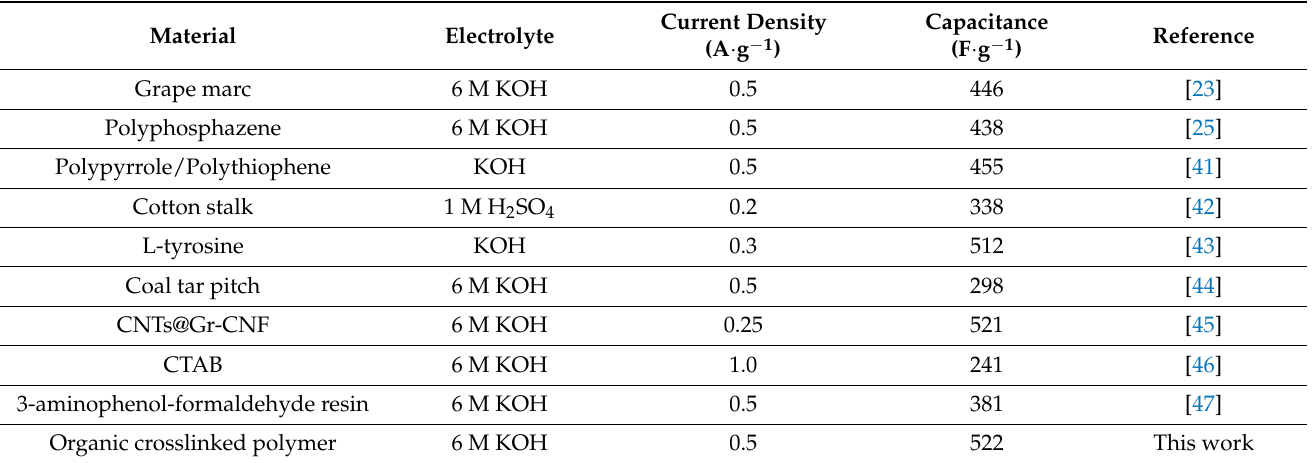
Table 3. Comparison of the specific capacitances of the C OCLP-4.5 electroactive material to recently reported carbonaceous